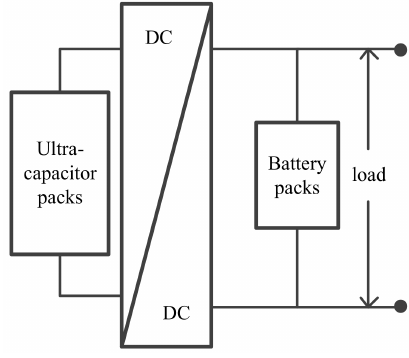
Figure 1. Semi-active with DC/DC and ultra-capacitor connection. Table 1. Basic parameters of the